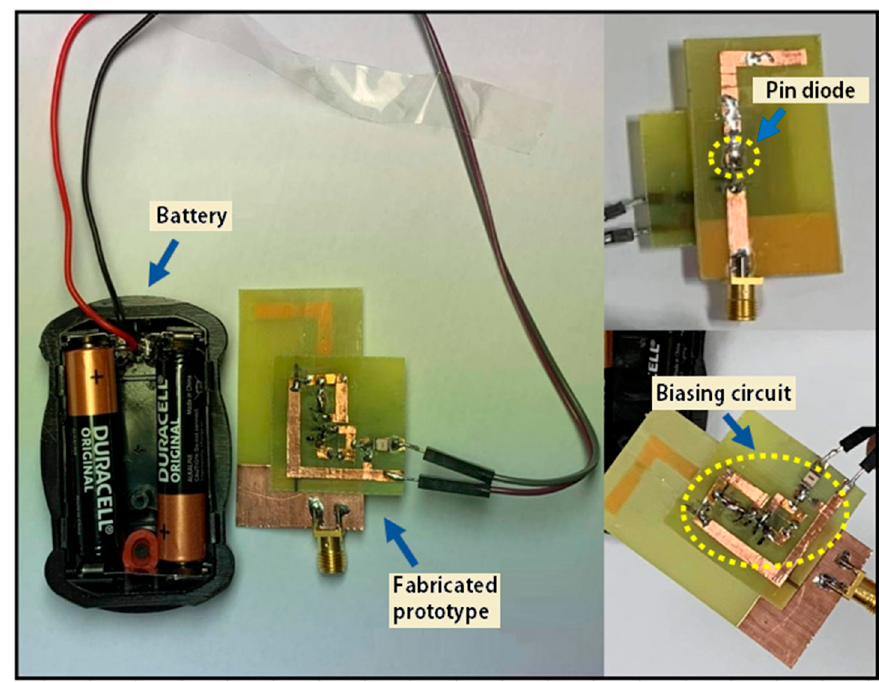
Figure 2. The view of fabricated prototype with biasing circuit. Table 1. Dimensions of proposed